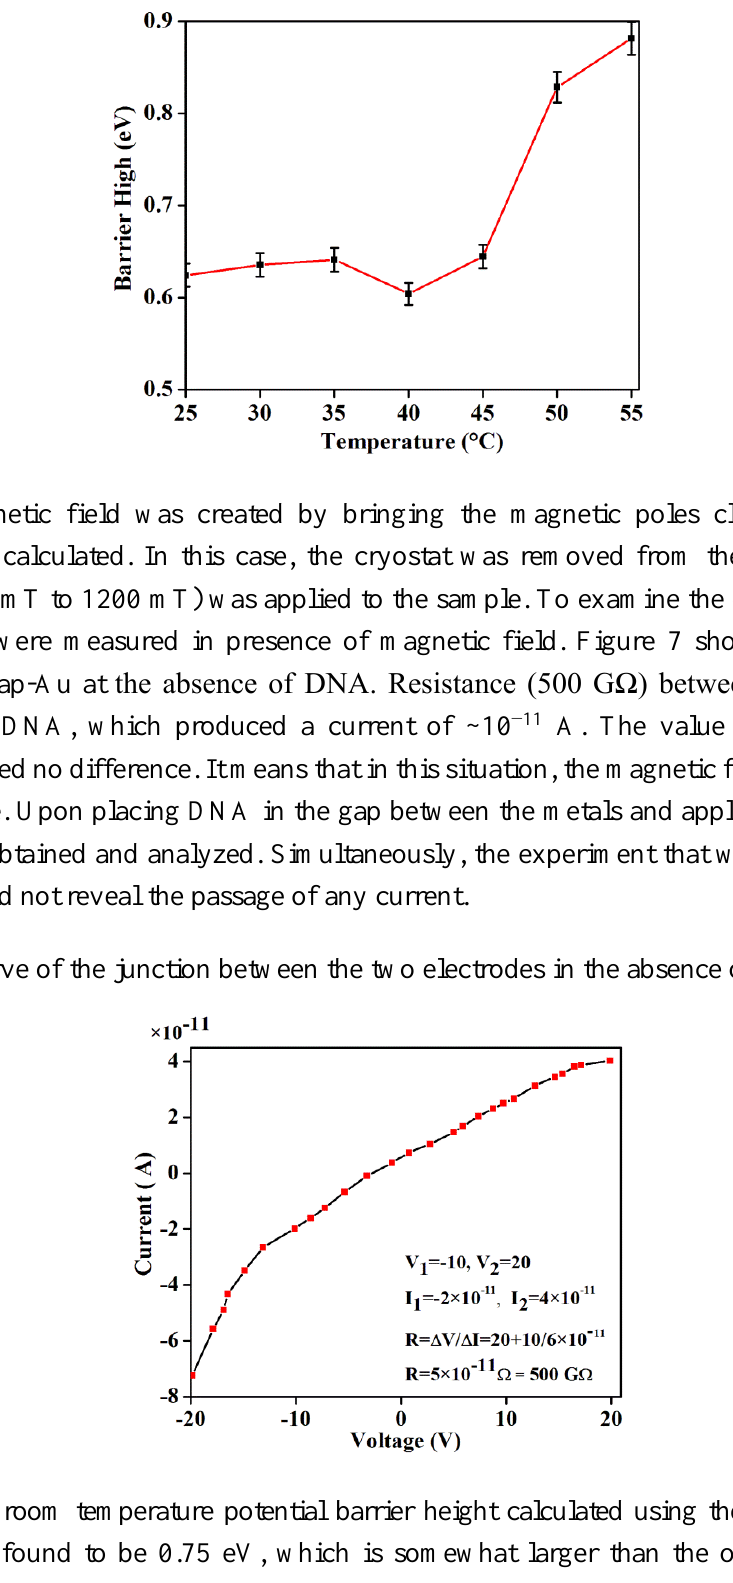
Figure 6. Temperature dependent potential barrier height in the absence of magnetic field.